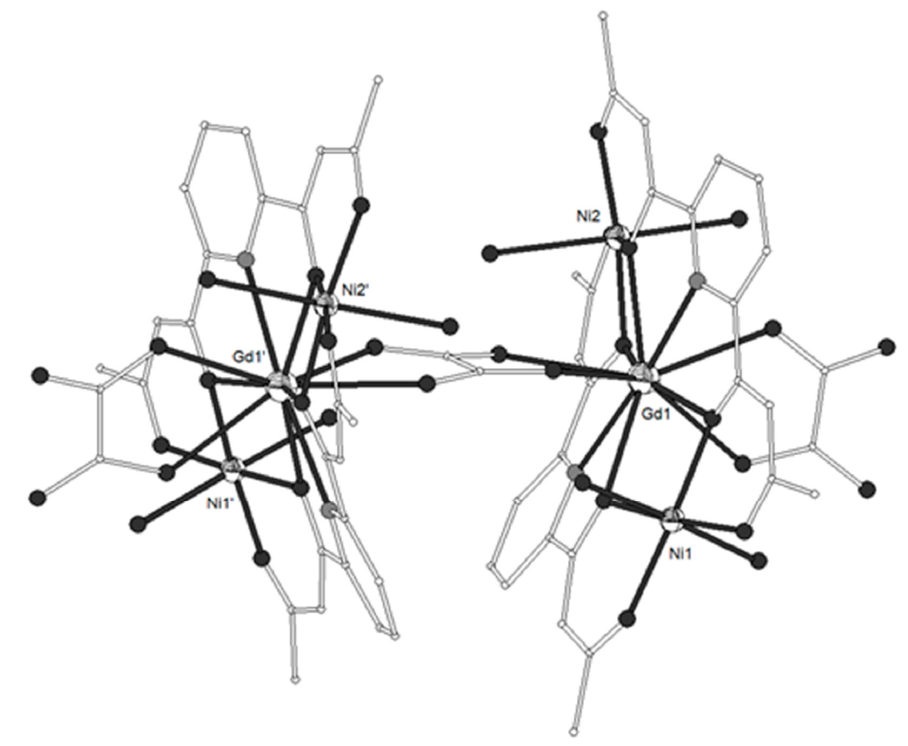
Figure 17. The molecular structure of complex [{Ni 2 (L 24 )Gd(H 2 O) 4 } 2 (C 2 O 4 ) 3 ] ( 147 ). Primed atoms are generated by symmetry (‘) − 1 − x , y , − 0.5 − z . Color code: Gd large octant, Ni small octant, N light grey, O dark grey, C open small [53].